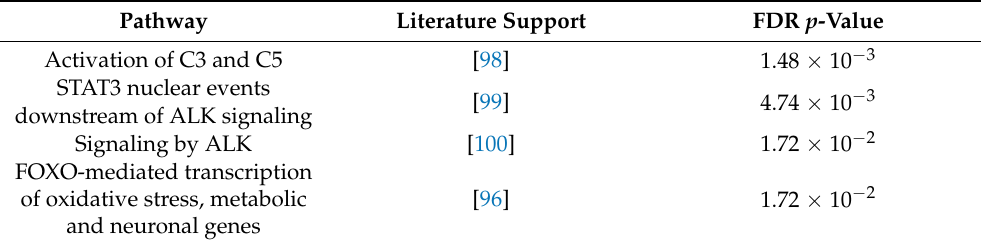
Table 6. Statistically Significantly Enriched READ Pathways: Most enriched pathways influenced by the genes with the largest hazard ratios are associated with increased risk in our TCGA-READ Cox model. p -value threshold <0.05 FDR. Hazard ratio threshold